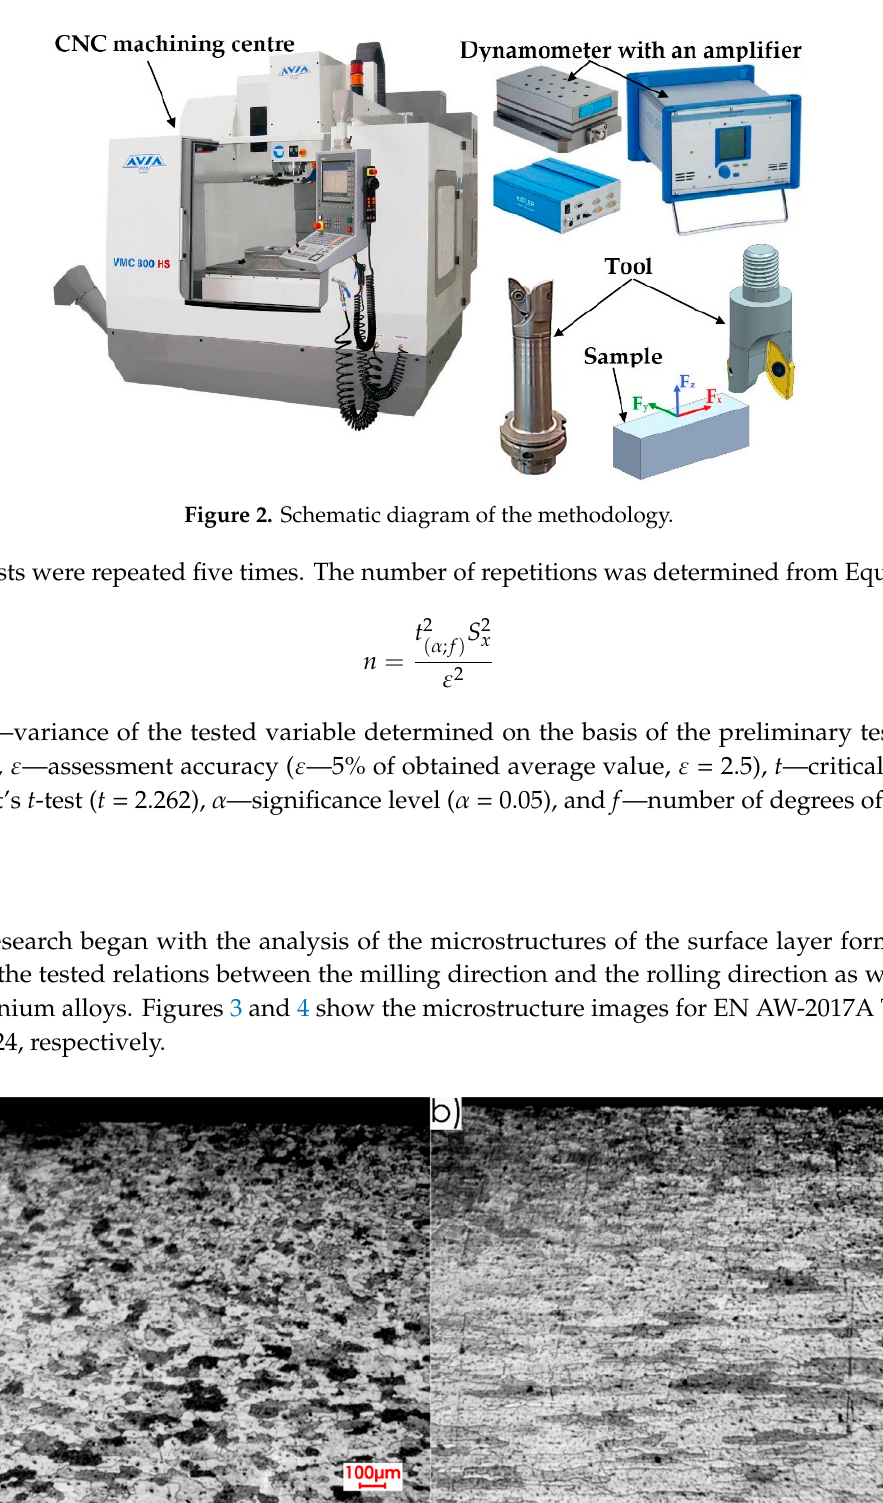
Figure 3. Microstructure of surface layer for EN AW-2017A T451 alloy: ( a ) perpendicular rolling direction, ( b ) parallel rolling direction (2.5× magnification).